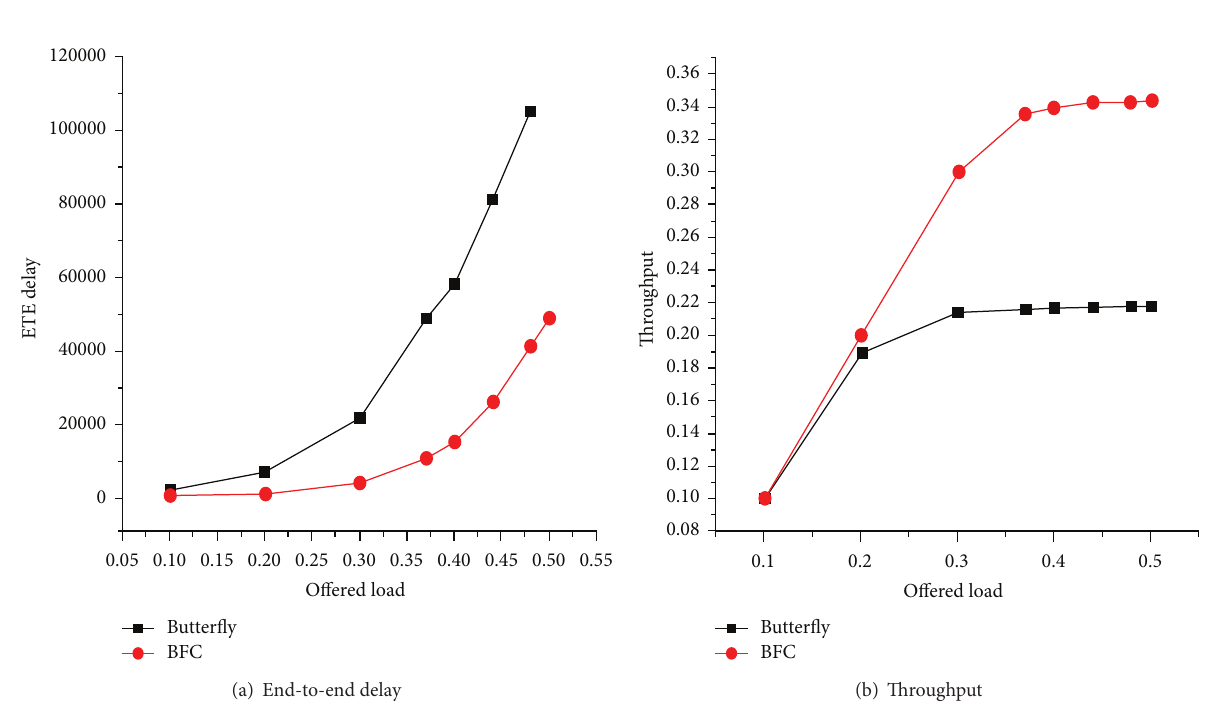
Figure 15: Performance comparison of two hot spots traffic